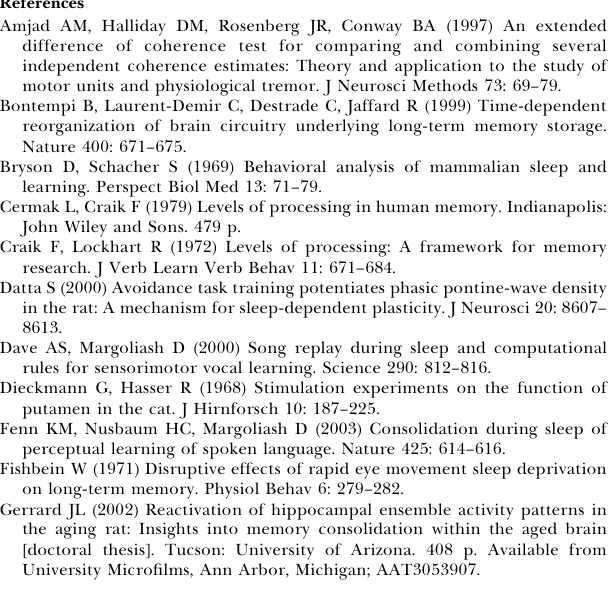
Figure S6. Neuronal Yield